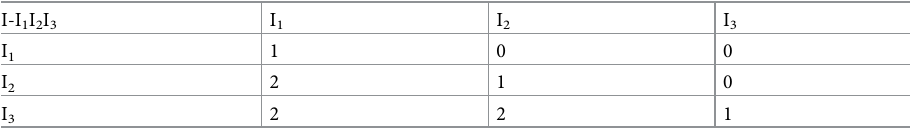
Table 6. Impact comparison matrix.